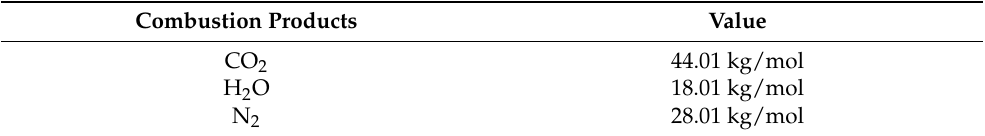
Table 3. Molar Mass of Combustion products.